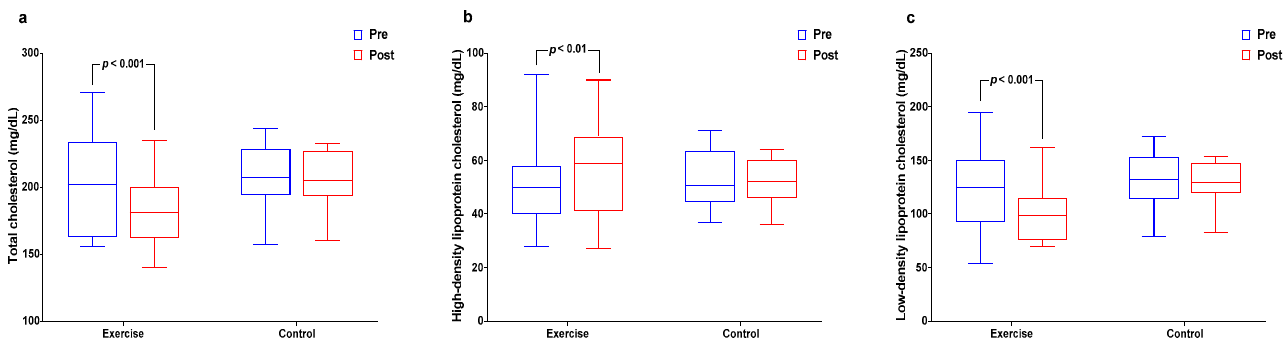
Figure 3. Effect of 12 weeks of aquatic exercise on cardiovascular risk factors in elderly Korean women. ( a ) TC of the exercise group significantly decreased ( p < 0.001); ( b ) HDL-C of exercise group increased significantly ( p < 0.01); ( c ) LDL-C of the exercise group was significantly decreased ( p < 0.001). TC: total cholesterol, HDL-C: high-density lipoprotein cholesterol, LDL-C: low-density lipoprotein cholesterol.